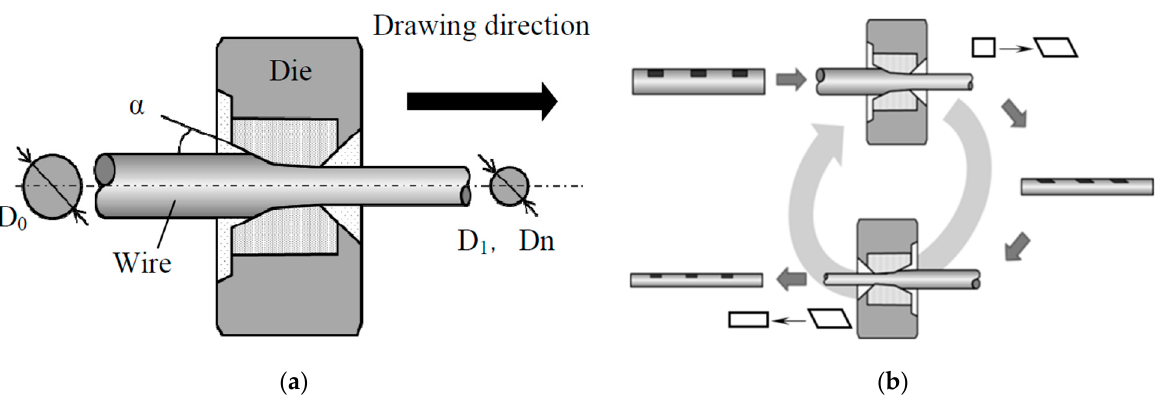
Figure 29. Wire drawing process: ( a ) conventional drawing and ( b ) novel alternative wire drawing. Reprinted with permission from ref. [70].